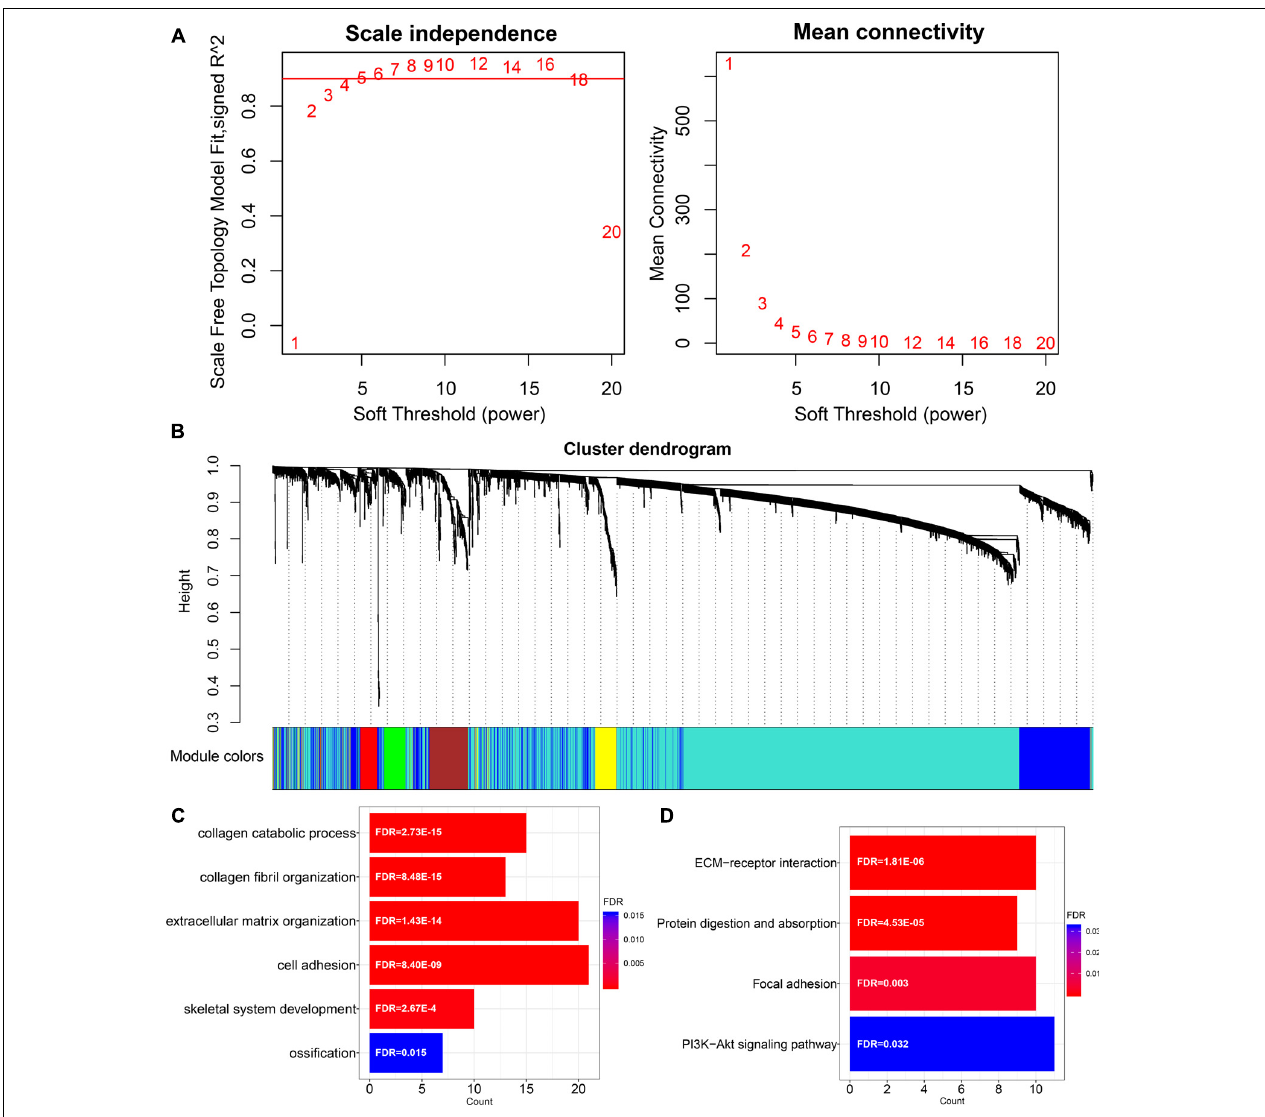
FIGURE 2 | Construction and functional enrichment analysis of LINC00941 co-expression network. (A) Scale-free topology index and mean connectivity were used to determine the soft threshold. (B) Clustering dendrogram of LINC00941 co-expression network. The genes are assigned to different modules that are distinguished by different colors. (C) The GO terms in LINC00941 co-expression model in GC. (D) The KEGG pathways in LINC00941 co-expression model in